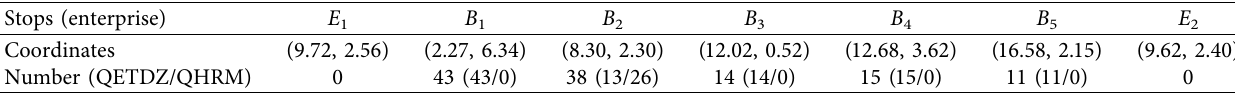
Table 6: Coordinates of stops and numbers of office workers.